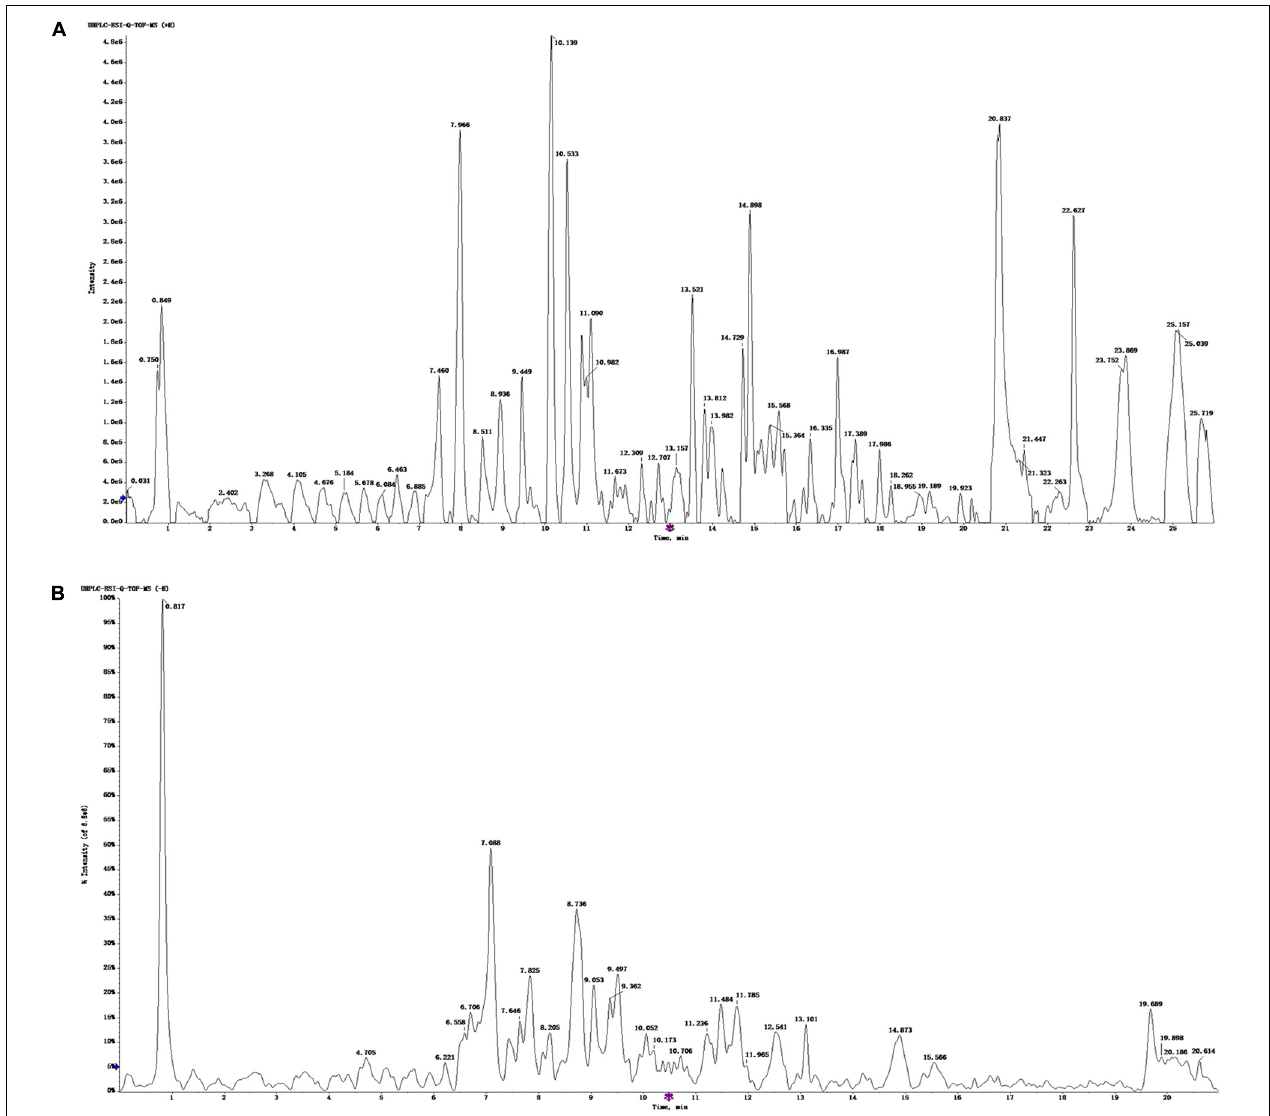
FIGURE 1 | UHPLC-ESI-Q-TOF-MS total ion chromatogram of ZBPYR. (A) Positive ion mode. (B) Negative ion mode.